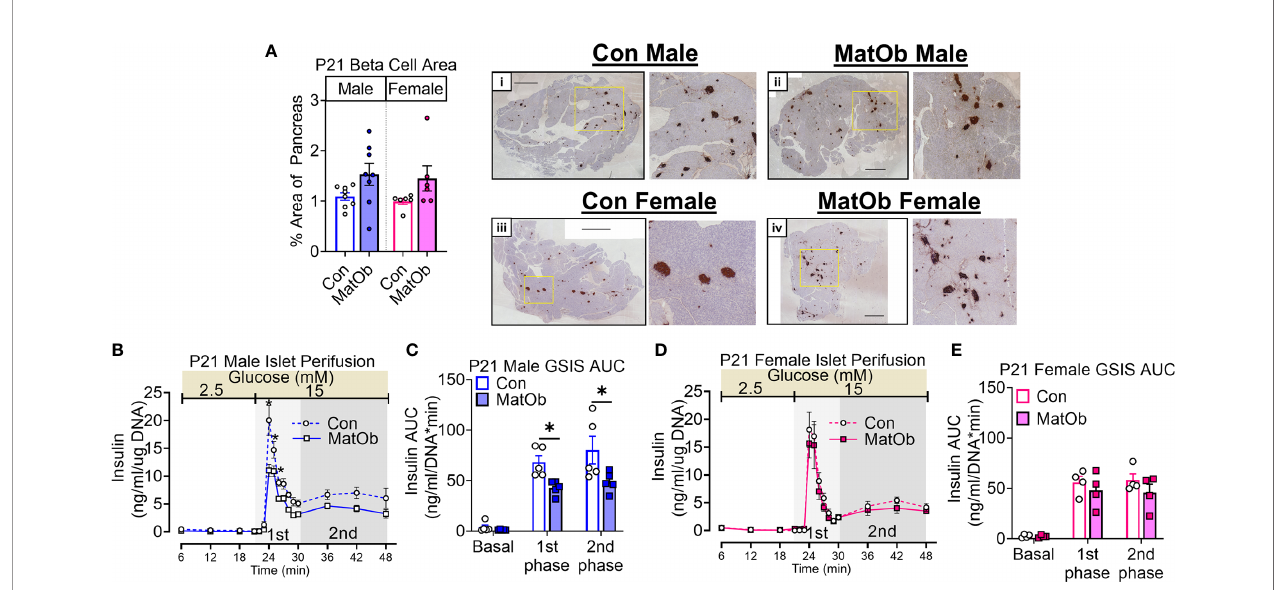
FIGURE 3 | P21 male MatOb offspring have decreased islet insulin secretion. (A) b cell area (n = 5 males, 7 females/group) was unchanged in both male and female MatOb offspring at P21. Representative IHC images of whole pancreatic sections with insulin staining (dark brown) and hematoxylin counterstain (Scale bar = 1000um) from (i) Con male, (ii) MatOb male, (iii) Con female, and (iv) MatOb female. Islet perifusion studies showing (B, C) decreased glucose-induced insulin secretion in P21 MatOb male offspring (n=5/group), and (D, E) unchanged glucose-induced insulin secretion in P21 MatOb female offspring (n=4/group). Experimental animals were originated from at least 3 separate litters (*p < 0.05).